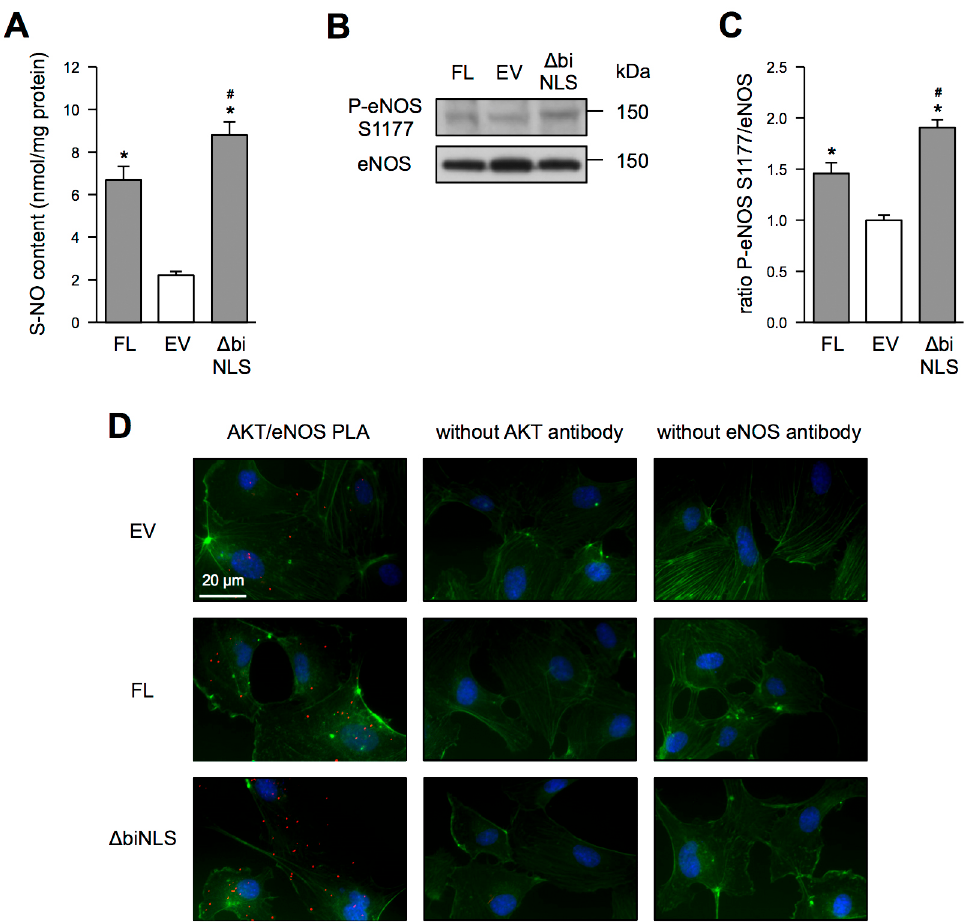
Figure 5. Effects of GRHL3 FL and GRHL3 ∆ biNLS on NO bioavailability, eNOS phosphorylation and interaction of Akt1 and eNOS. ( A – D ) EC were transfected with an empty vector (EV), GRHL3 FL or GRHL3 ∆ biNLS plasmids. ( A ) S-NO content was measured at 405 nm and calculated as nmol/mg protein (data are mean ± SEM, n = 5, * p < 0.05 vs. EV, # p < 0.05 vs. FL). ( B , C ) Phosphorylation of eNOS on serine 1177 was measured by immunoblot. ( B ) Representative immunoblot. The upper panel shows phosphorylation of eNOS on serine 1177. The lower panel shows comparable levels of total eNOS. ( C ) Semiquantitative analyses of the ratio of phosphorylated eNOS on serine 1177 to total eNOS (data are mean ± SEM, n = 5, * p < 0.05 vs. EV, # p < 0.05 vs. FL). ( D ) Proximity ligation assay (PLA) was performed with antibodies against AKT and eNOS (AKT/eNOS PLA, left panels). As negative controls, PLAs were performed, omitting either the AKT antibody (middle panels) or the eNOS antibody (right panels). Red dots represent AKT and eNOS interactions. The actin cytoskeleton was stained with Phalloidin (green) and nuclei with DAPI